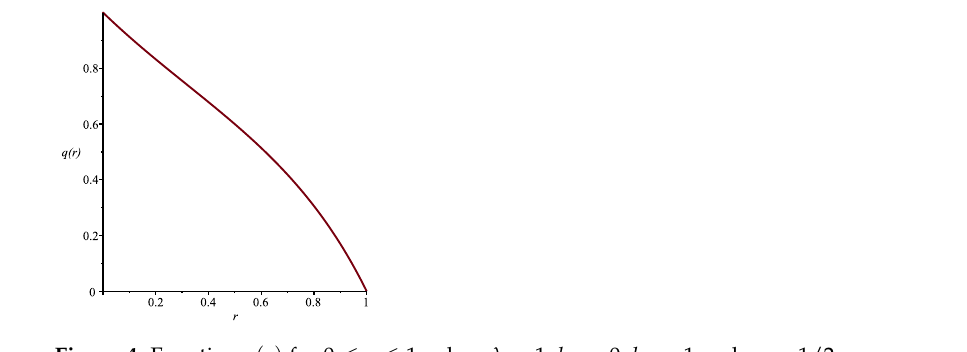
Figure 4. Function q ( r ) for 0 ≤ r ≤ 1, when λ = 1, k 1 = 0, k 2 = 1 and p 0 =